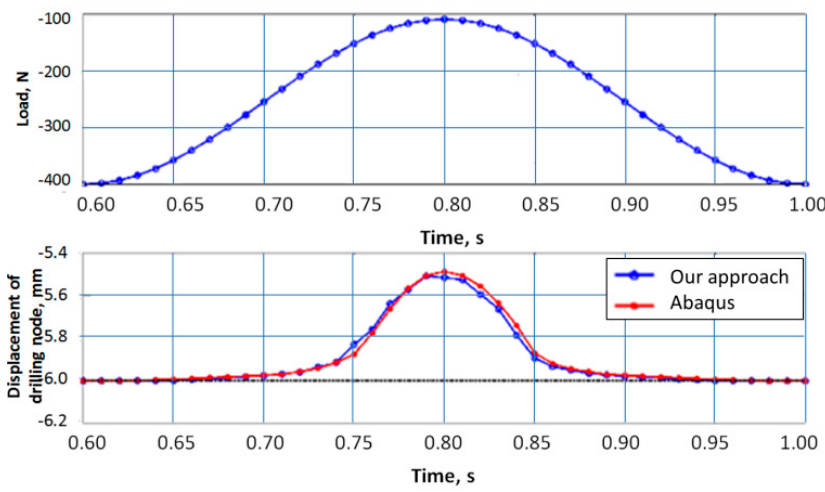
Figure 3. Load ( above ) and displacement ( below ) at the drilling point at times from 0.6 s to 1.0 s.